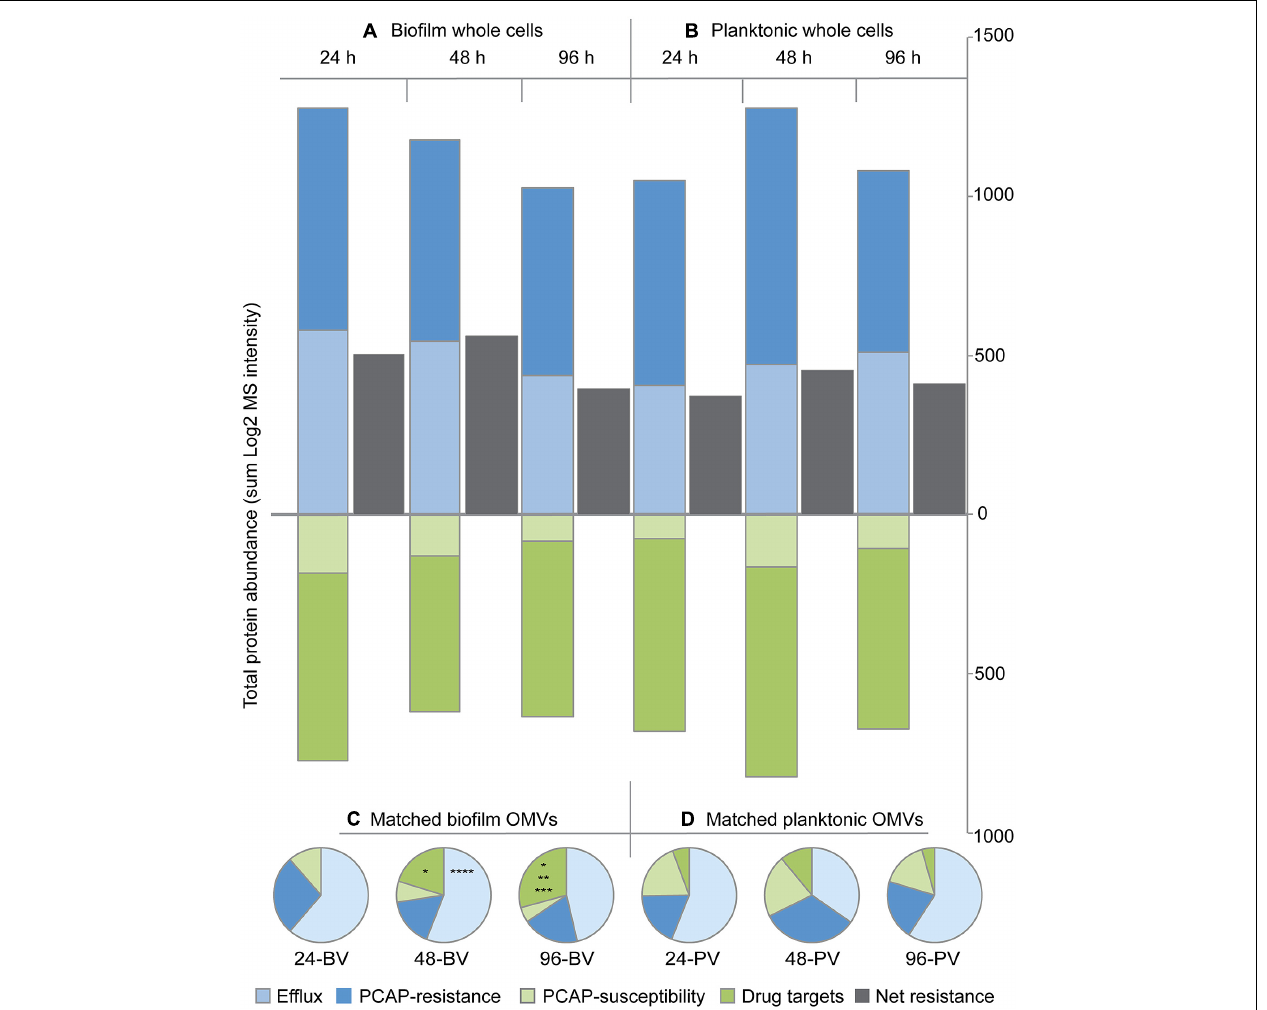
FIGURE 5 | Protein abundance totals for functional categories indicate that biofilm OMVs are more distinct than biofilm whole cells when compared to their planktonic counterparts. Bar graphs showing the total protein abundance for biofilm (A) and planktonic (B) whole cell replicate groups in each of the four functional categories over time. Net whole cell resistance [i.e., (efflux + PCAP-resistance proteins) – (drug targets + PCAP susceptibility proteins)] is shown in